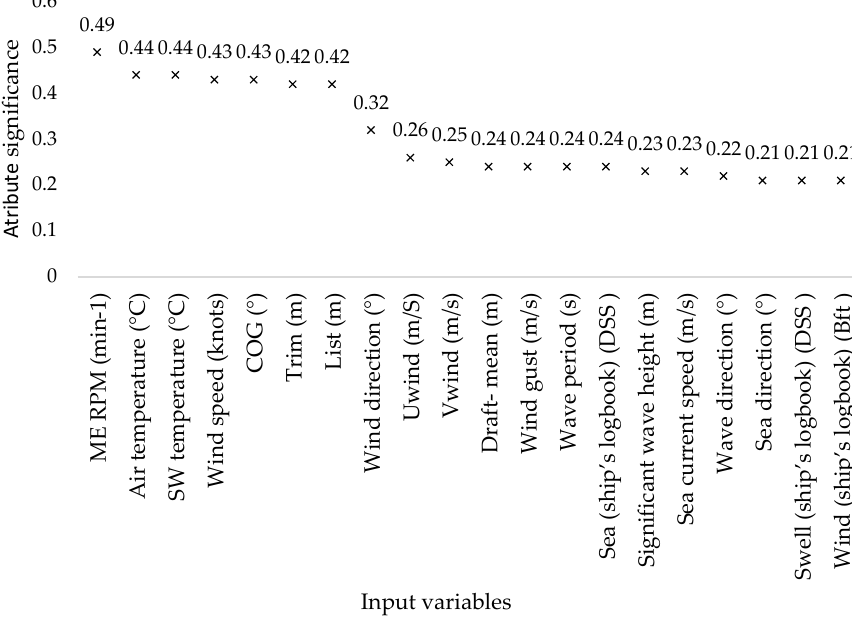
Figure 1. Significance of individual variables (attributes) in the construction of random forest model.